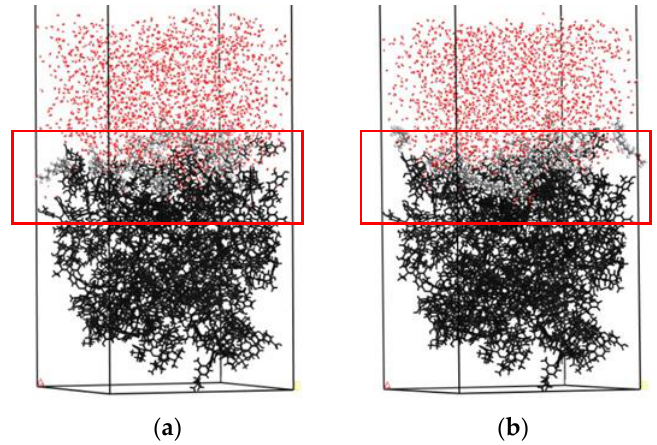
Figure 8. The equilibrium adsorption configuration on the surface of Bulianta coal in an aqueous environment: ( a ) Water/methyl laurate/coal system and ( b ) water/dodecanol/coal. For clarity, the coal surface models are shown as black.